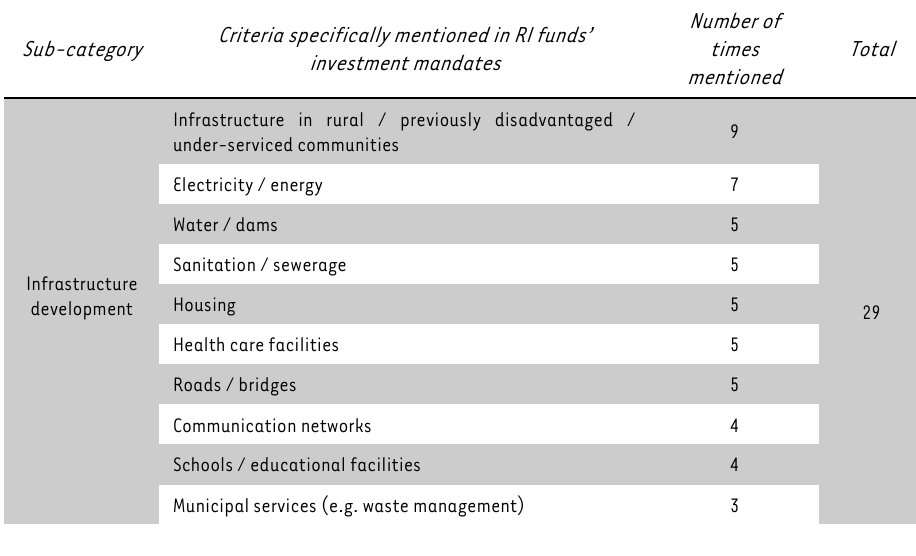
Social criteria used by South African RI asset managers over the period 1 June 1992– 31 December